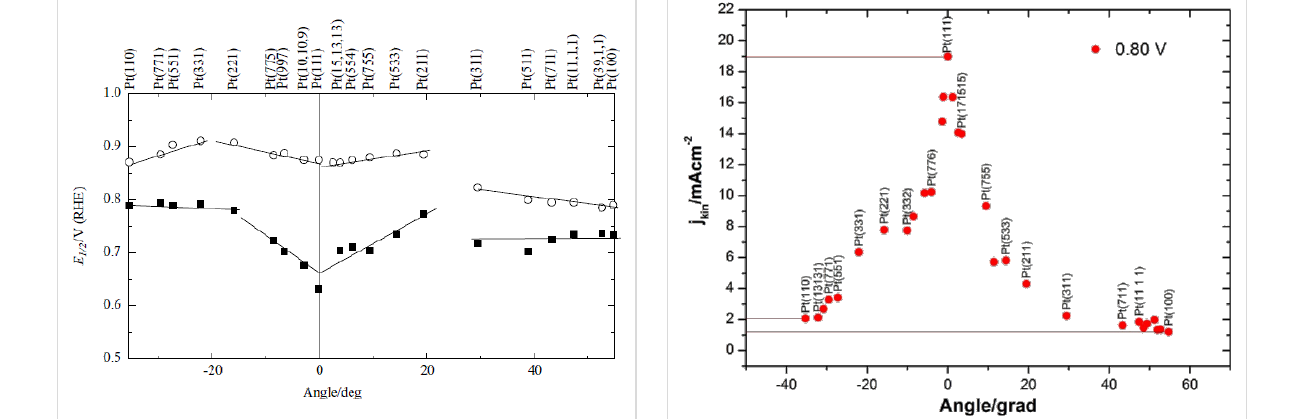
described above [13,60-62]. Similarly, theoretical and experi- mental results for Pt(110) and Pt(100) also disagrees.